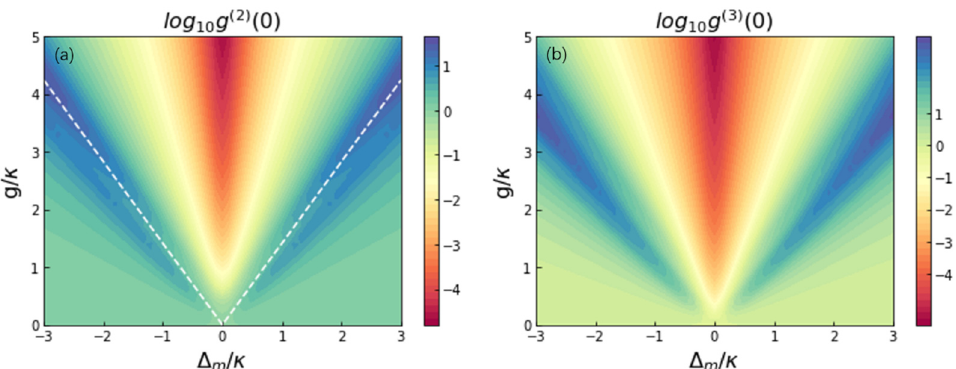
Figure 2. Steady-state equal-time ( a ) second-order correlation function g ( 2 ) ( 0 ) and ( b ) third-order correlation function g ( 3 ) ( 0 ) versus the detuning ∆ m / κ . and the coupling strength g / κ when the mechanical resonator is weakly driven. The system parameters we take are γ = 0.01 κ , ε b = 0.15 κ and n th = 0. The white dashed curve in ( a ) corresponds to the case of two-phonon resonant driving, √ 2 g i.e., ∆ m = ± 𝑔 .